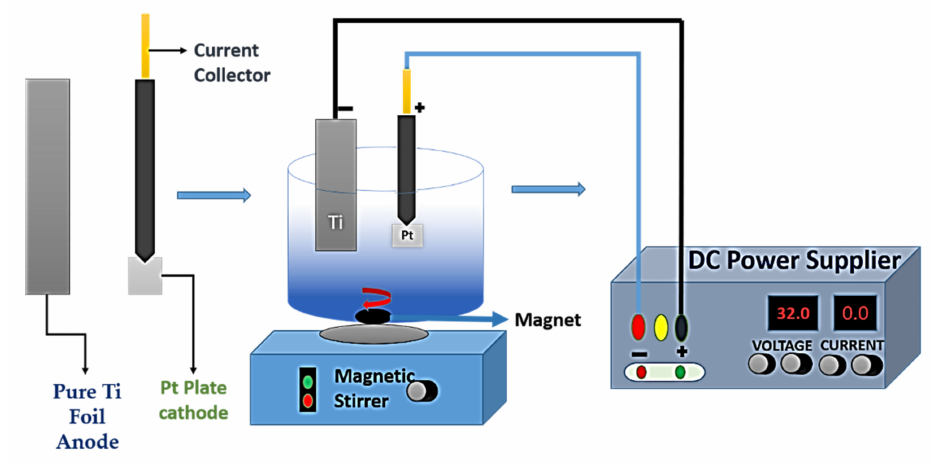
Figure 14. The anodization of pure Ti foil.